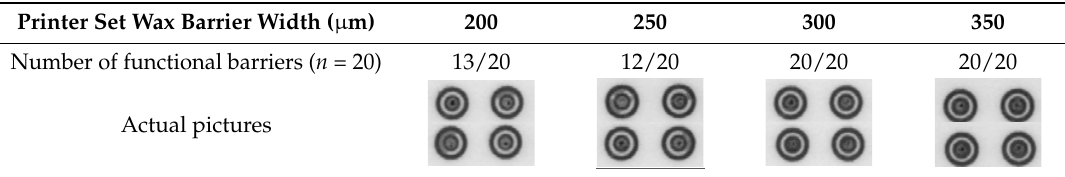
Figure 3. Schematic of the experimental method used to evaluate the minimally required wax barrier width. The indicated dimensions ( x = 200–350 µm) refer to the values set for wax printing and do not represent the actual dimensions obtained after hot lamination. Table 1. Evaluation of minimally required printed wax barrier width (images converted to grayscale and contrast adjusted for improved visibility).